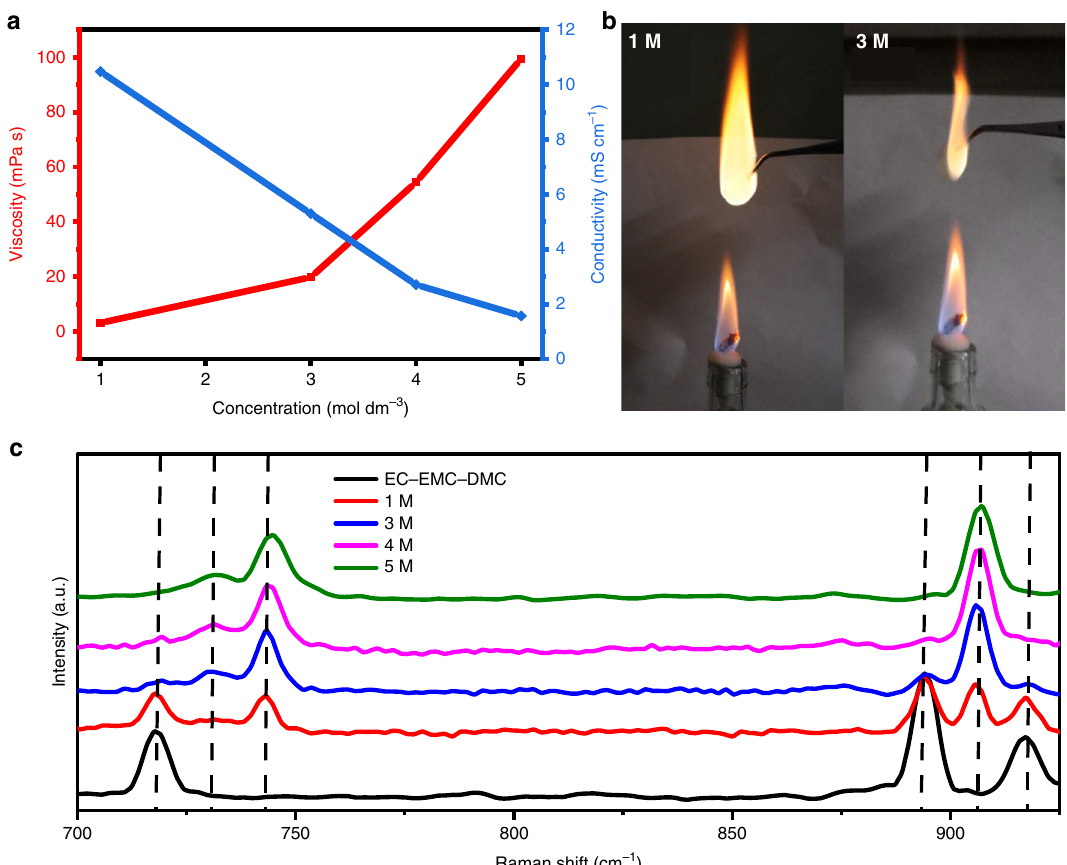
Fig. 2 Physicochemical properties and Raman spectra dependent on salt concentration. a Viscosity and ionic conductivity for electrolyte of LiPF 6 in